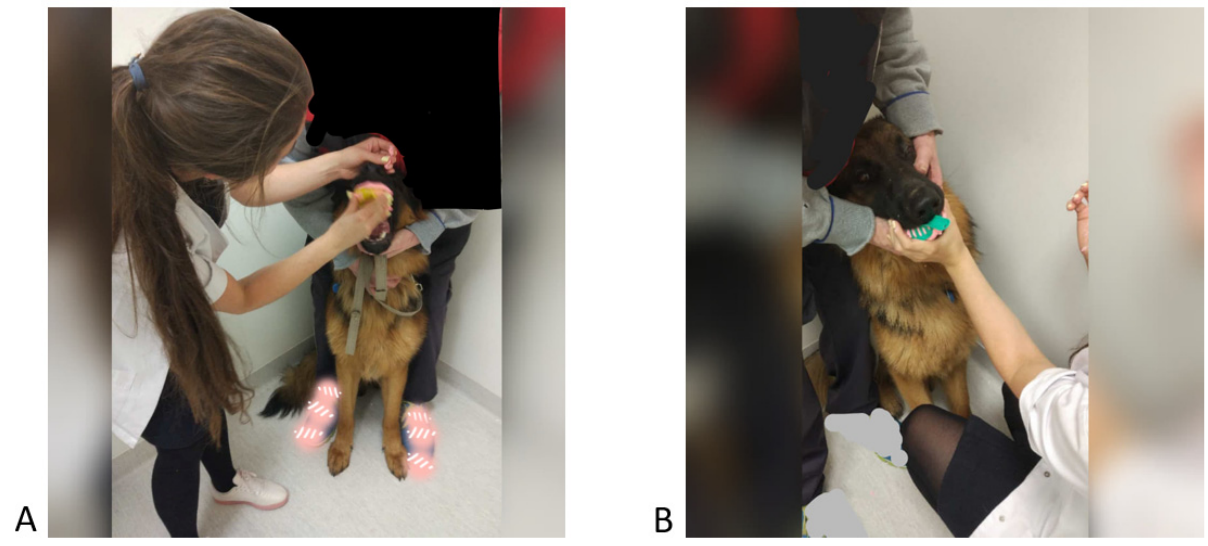
Figure 13. Taking impressions of the maxillary ( A ) and mandibular ( B ) arches of the